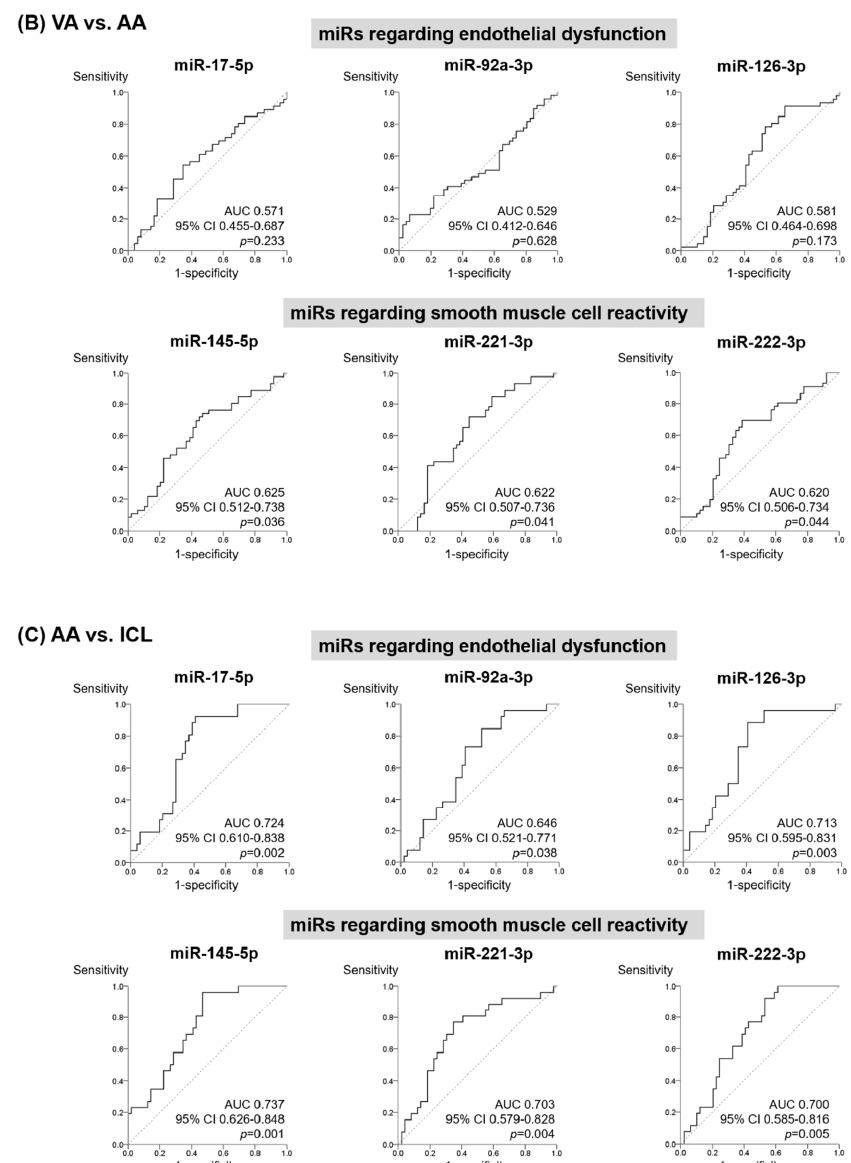
Figure 3. Distinction of patients according to miR profile. In the receiver operating characteristics curve analysis, the area under the curve and 95% confidence intervals were calculated between ( A ) VA group ( n = 46) group and ICL groups ( n = 26), ( B ) VA group and AA group ( n = 49), and ( C ) AA group and ICL group. AA, atherothrombotic angina; AUC, area under the curve; CI, confidence interval; ICL, Insignificant coronary lesion; VA, vasospastic angina; miR, microRNA.